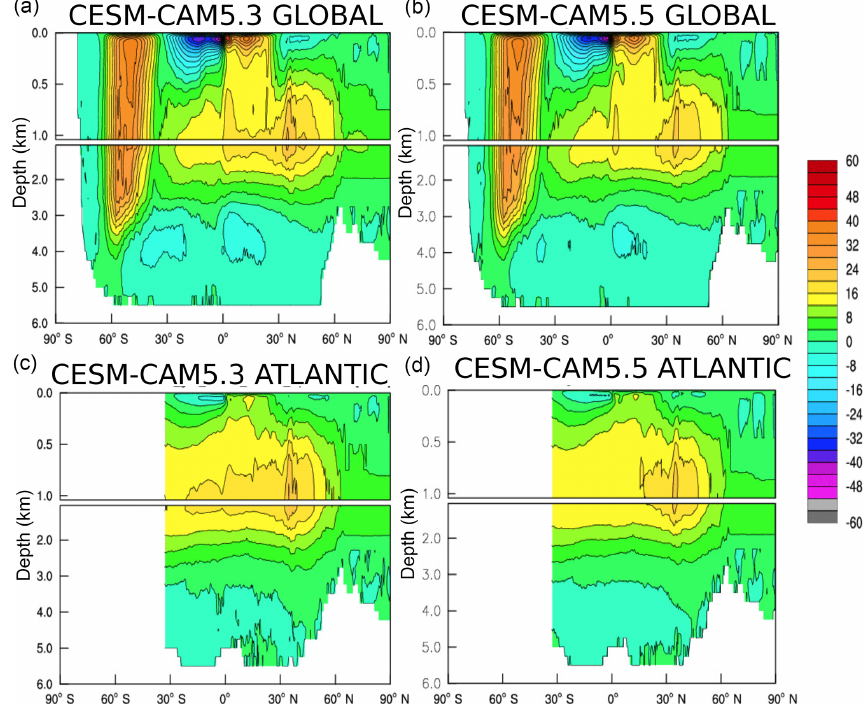
Figure 11. Global meridional overturning circulation (MOC, a and b ) and Atlantic MOC ( c and d ) for CESM-CAM5.3 ( a and c ) and CESM-CAM5.5 ( b and d ). Units are